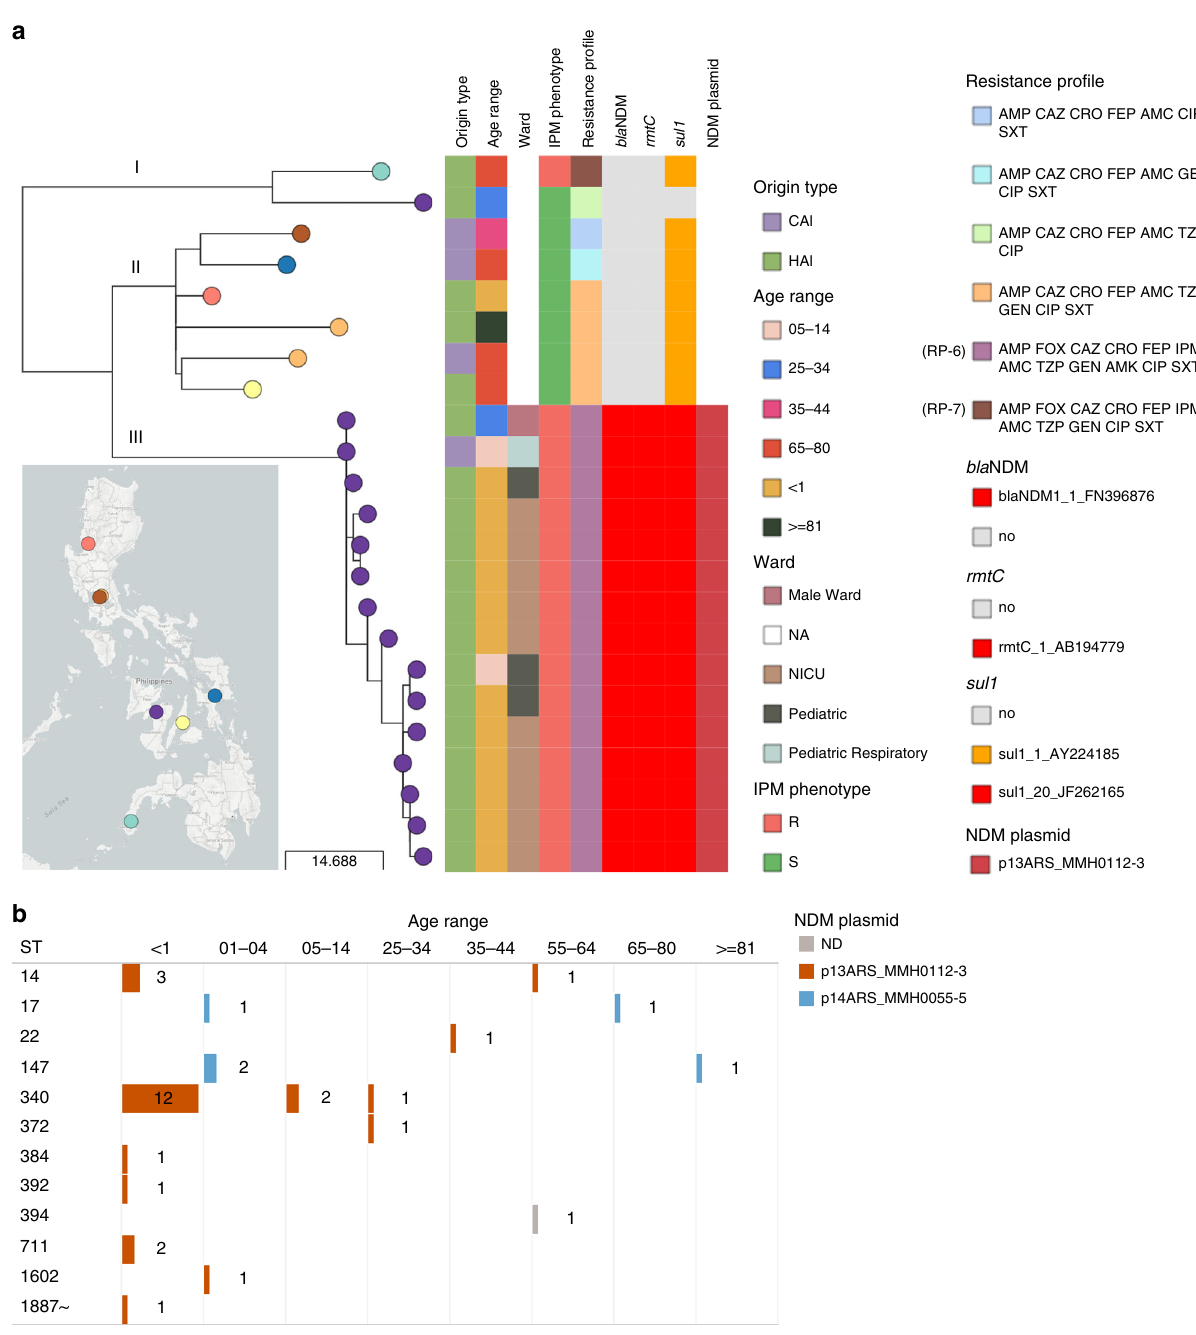
Fig. 4 Detection of a plasmid-driven outbreak of K. pneumoniae ST340. a Phylogenetic tree and linked epidemiological and genotypic data of 24 retrospective ST340 genomes. Origin type de fi ned as either community-acquired infection (CAI) or hospital-acquired infection (HAI). NA ward information not available. The imipenem (IPM) phenotype was either resistant (R) or susceptible (S). The three-letter antibiotic codes in the resistance pro fi les are as in Table 1. This interactive view is available at https://microreact.org/project/ARSP_KPN_ST340_2013-14/ac2a0920. The maximum- likelihood tree was inferred from 196 SNP positions identi fi ed by mapping the genomes to reference CAV1217 (CP018676.1 [https://www.ncbi.nlm.nih. gov/nuccore/CP018676.1]), and masking regions corresponding to mobile genetic elements and recombination. The scale bar shows the number of SNPs per variable site. The full data are available at https://microreact.org/project/ARSP_KPN_ST340_2013-14. b Distribution of 33 isolates from hospital MMH with resistance pro fi le RP-6 by patient age group, sequence types (ST) and NDM plasmid. Short reads of the 33 isolates were mapped to the plasmid sequences and a match was counted when the reads covered at least 95% of the sequence length with at least 5× depth of coverage. ND not